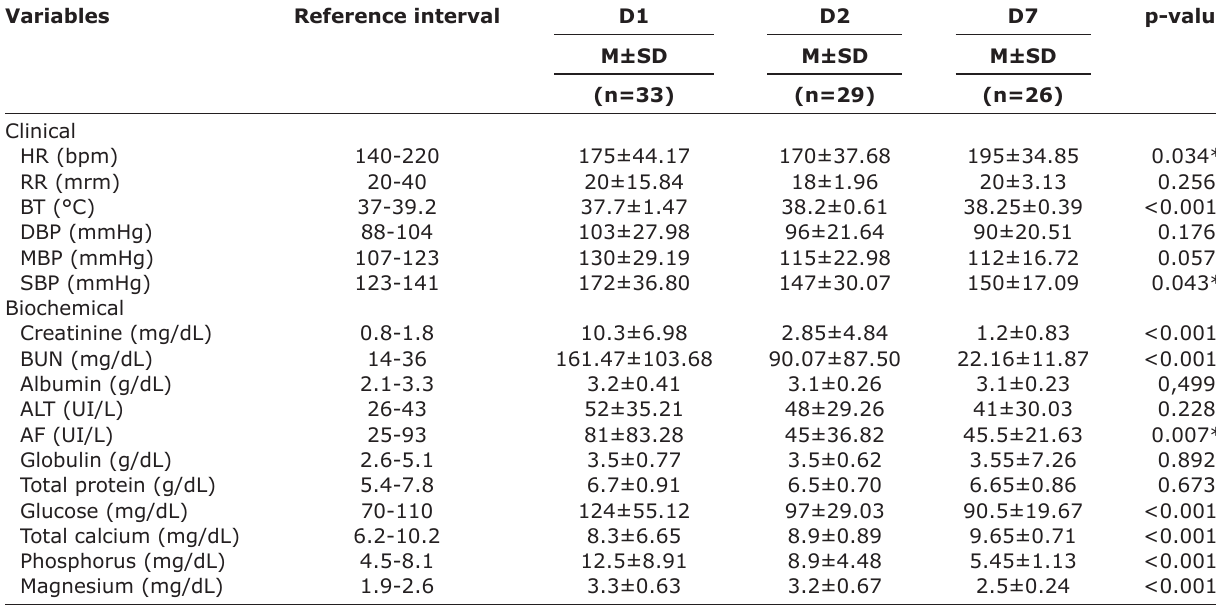
Table-1: Descriptive statistics and univariate analysis of the clinical and biochemical of cats with UO of the study at times D1, D2, and D7. Variables